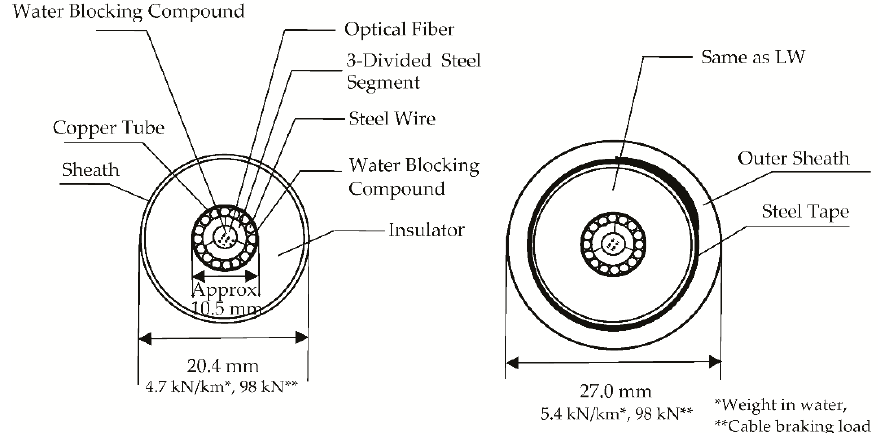
Figure 3. Cable construction (cross-sections) of LW cable ( left ) and LWS cable ( right